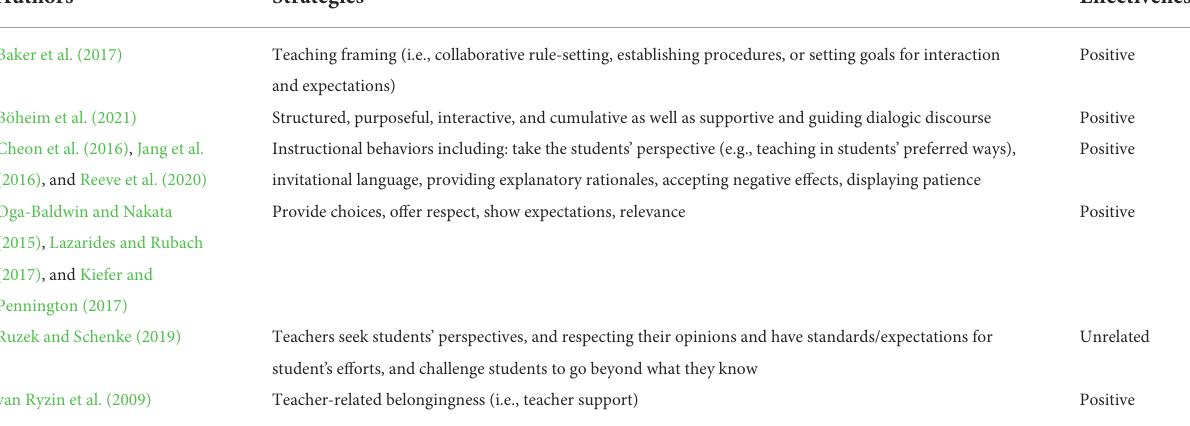
TABLE 12 Autonomy supportive strategies used to promote student engagement (examples).